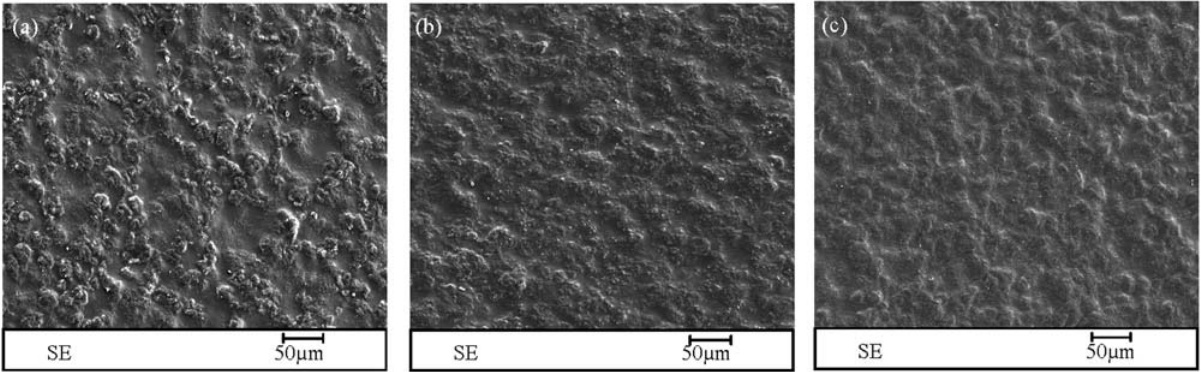
Figure 4: SEM photographs of the surface of composite fi lms: ( a ) without ε - polylysine, ( b ) containing 10 wt% of ε - polylysine and ( c ) containing 20 wt% of ε - polylysine.